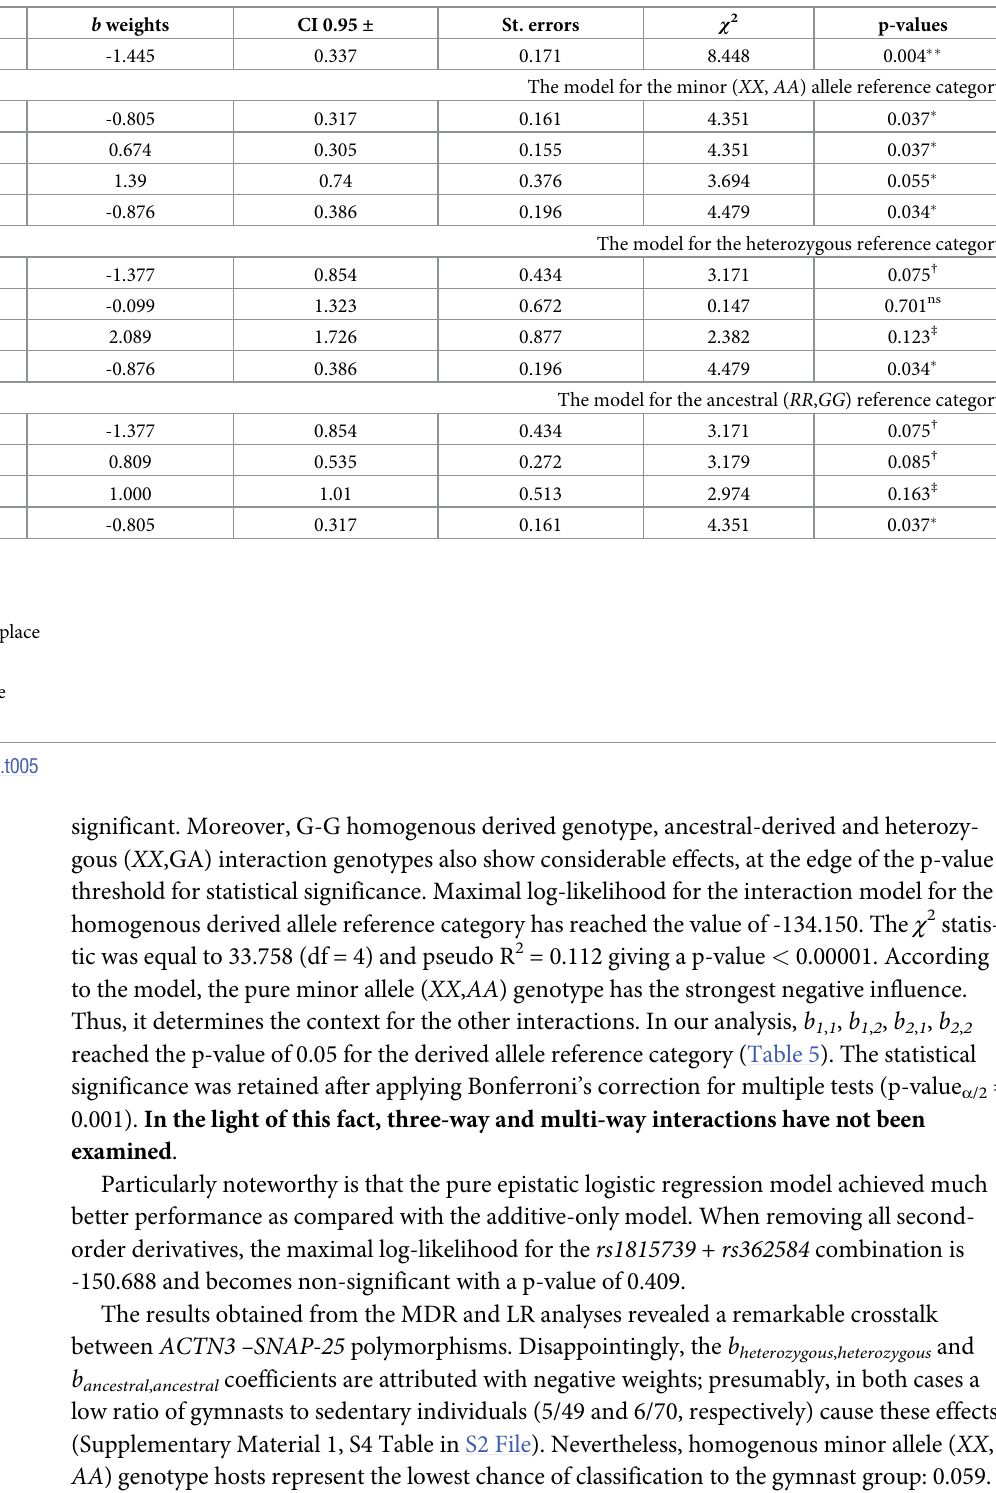
Table 5. The ACTN3 –SNAP-25 interaction